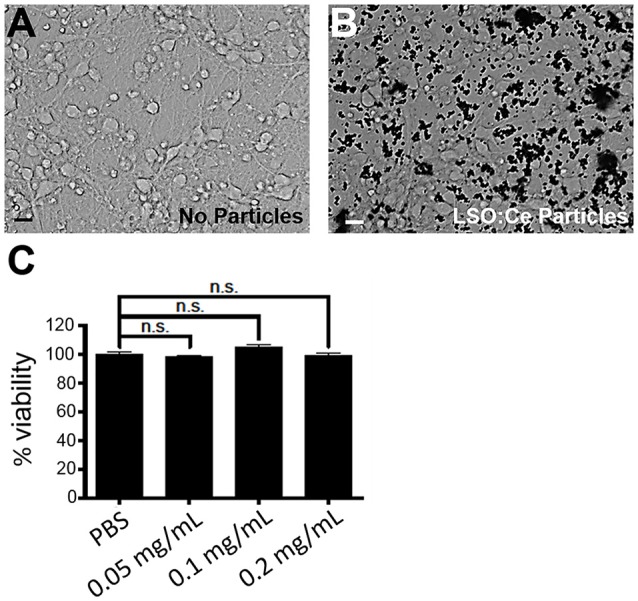
Prolonged exposure of LSO:Ce microparticles is not toxic to neurons. (A) Representative image of primary cortical neurons at 11 days in vitro (DIV). (B) Representative image of 11 DIV primary cortical culture that were incubated with LSO:Ce particles (black dots) for 24 h. (C) Group data for indicated LSO:Ce particles concentrations that were added to the neurons at 10 DIV and the cell death assay was performed on DIV 11 using Alamar Blue reagent. Results are expressed as percent of control. Data represent as mean ± SEM, n = 6 wells per condition, one-way ANOVA with Tukey’s post hoc test. n.s, not significant. Scale bars: 25 μm.